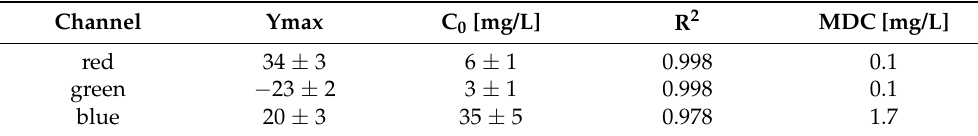
Figure 5. Colorimetric sensor calibration curves. Table 1. Parameters of best fit of sensor responses with the Michaelis–Menten equation, the errors are calculated with 95% of confidence